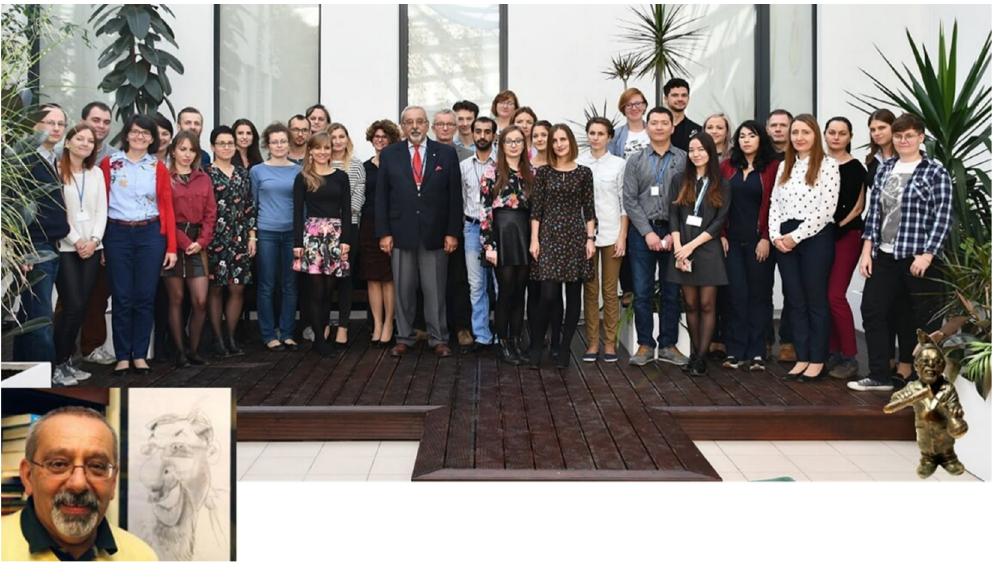
Figure 10. Toru ń ’s chromatography school, Prof. Bogus ł aw Buszewski with his students. Figure 10. Toru´n’s chromatography school, Prof. Bogusław Buszewski with his